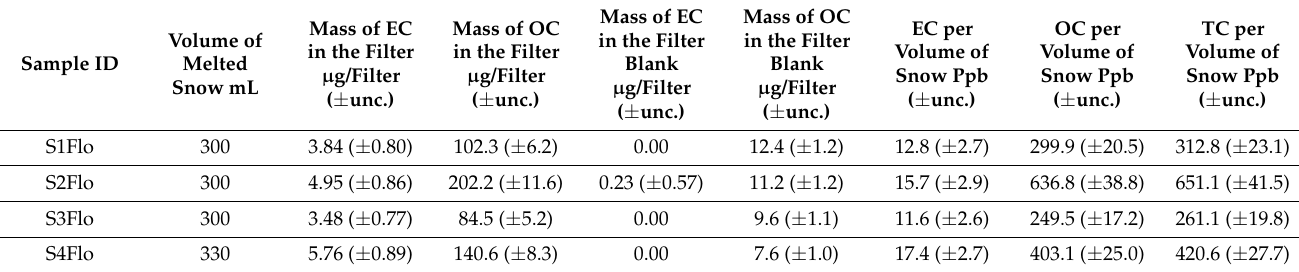
Table 1. Results of the University of Florence snow sample